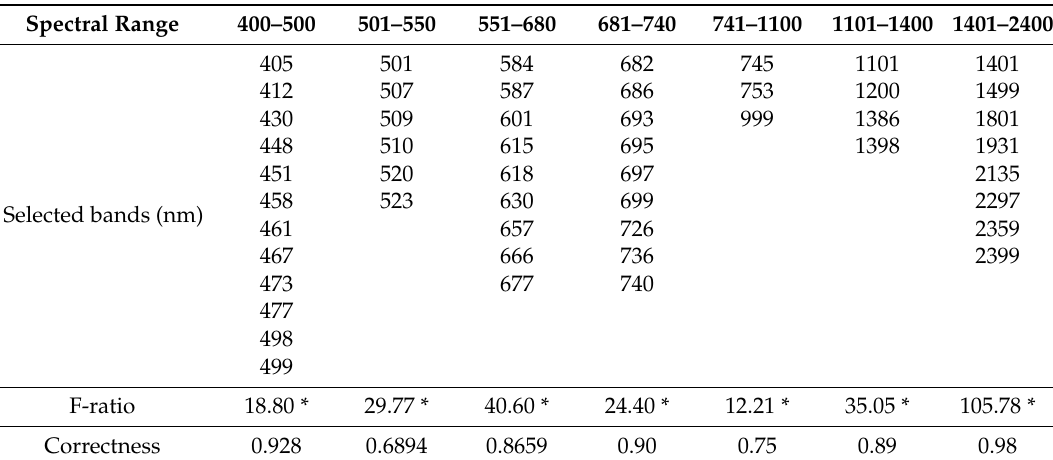
Table 5. Best bands found within selected spectral regions.